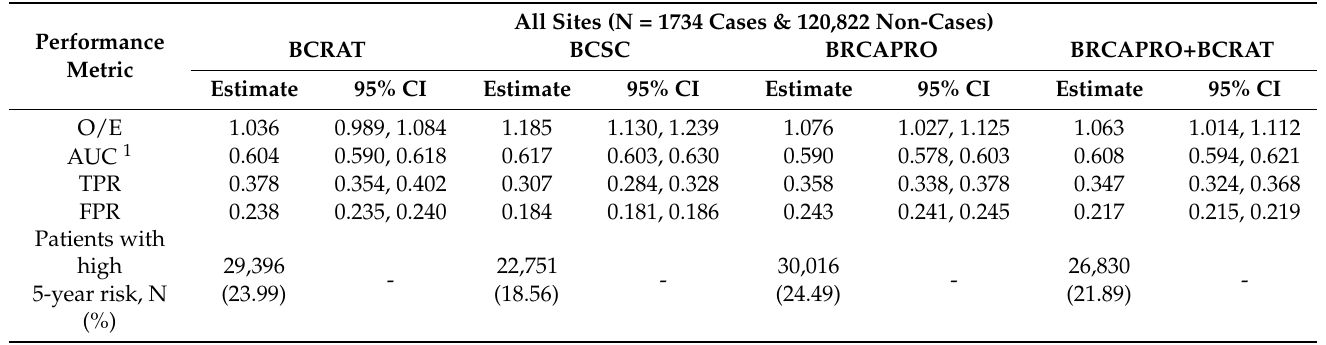
Table 2. Overall performance of risk models 1 .